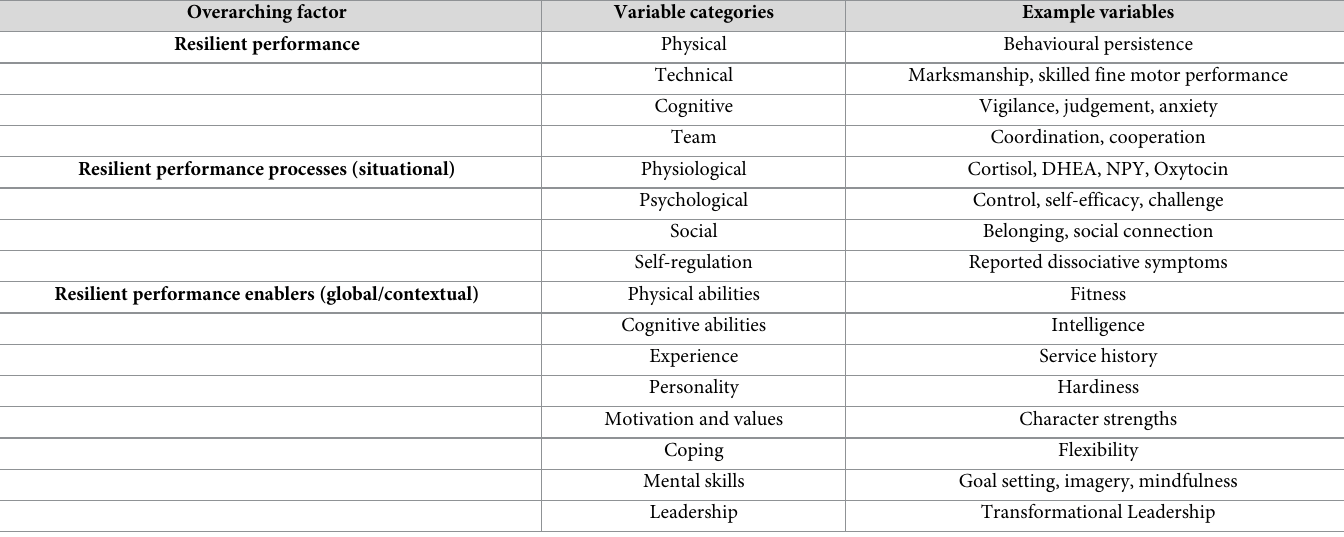
Table 2. Organisation of the resilient performance framework. Developed based on the systematic literature review presented here, and principles identified in the broader resilient performance literature. Overarching